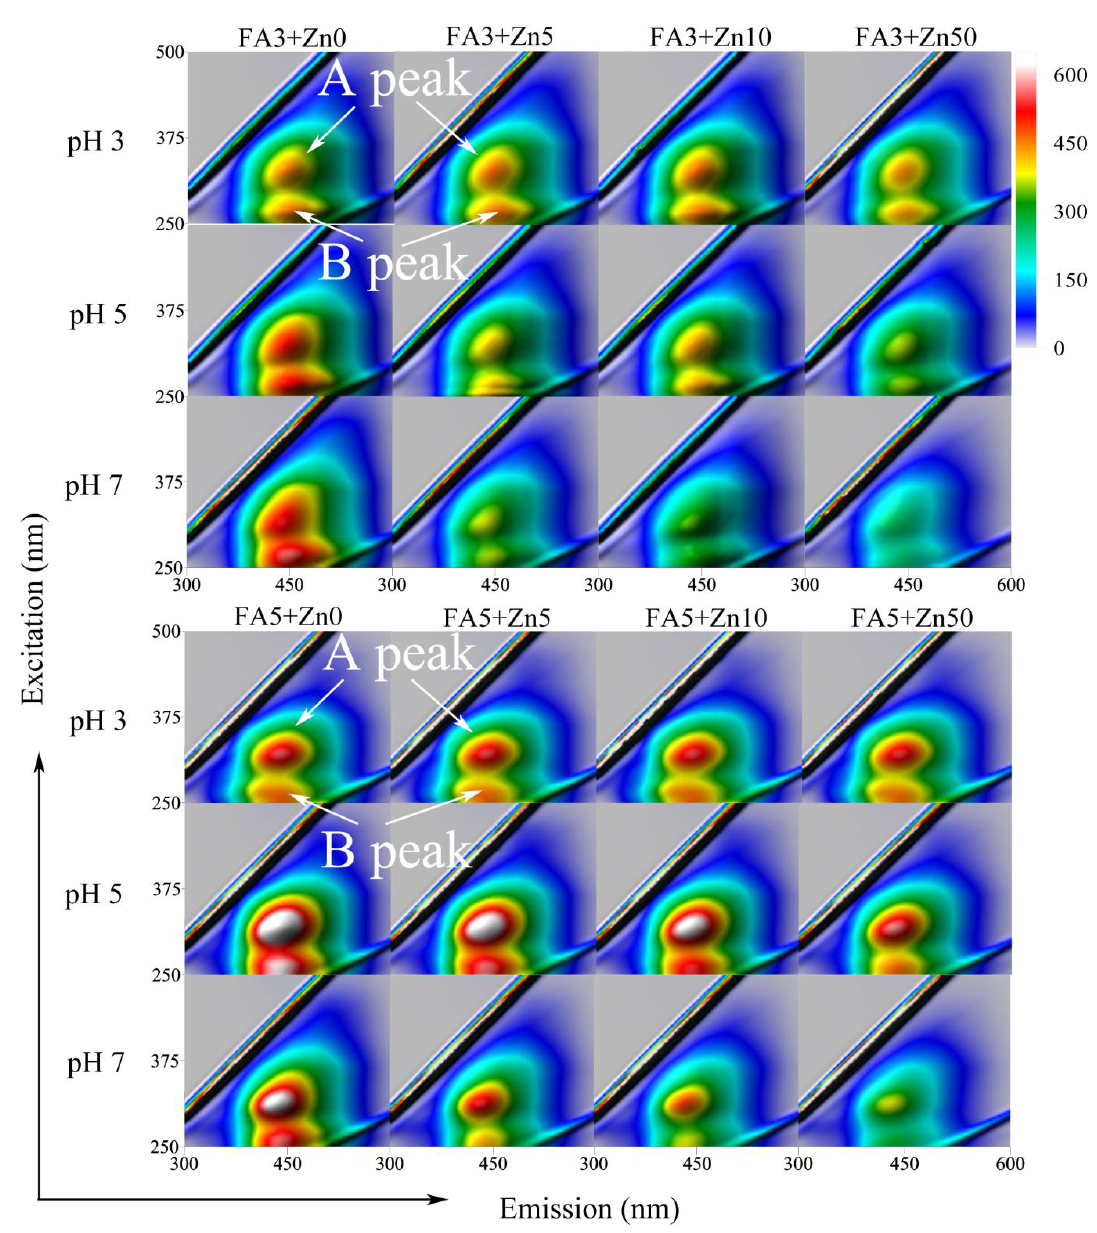
Figure 1. Excitation-emission matrices (EEM) for FAs and FAs-Zn(II) solutions as a function of increasing pH and Zn concentrations.